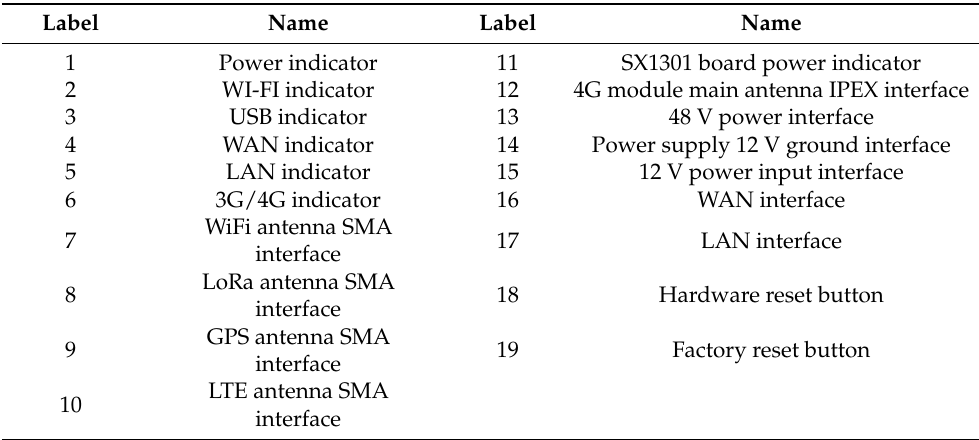
Figure 20. Terminal node module prototype.